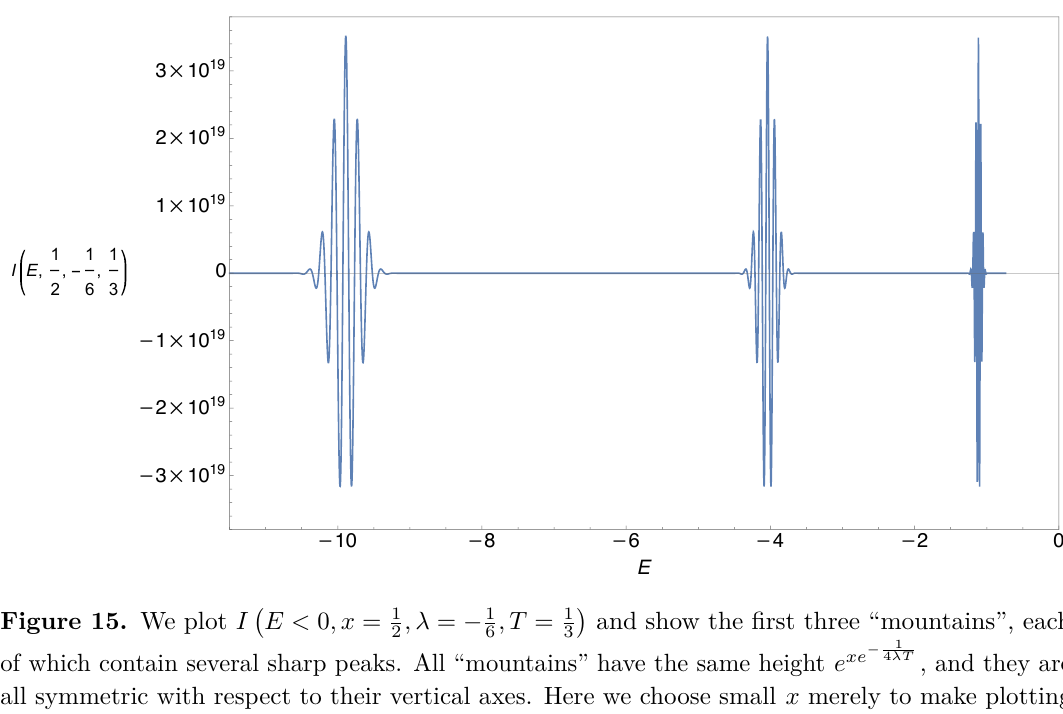
(cid:0) (cid:1) and show the first three “mountains”, each Figure 15. We plot I E < 0 , x = 1 , λ = − 1 , T = 1 2 6 3 of which contain several sharp peaks. All “mountains” have the same height e xe − 1 4 λT , and they are all symmetric with respect to their vertical axes. Here we choose small x merely to make plotting easy, but yet the peaks are already sharp and